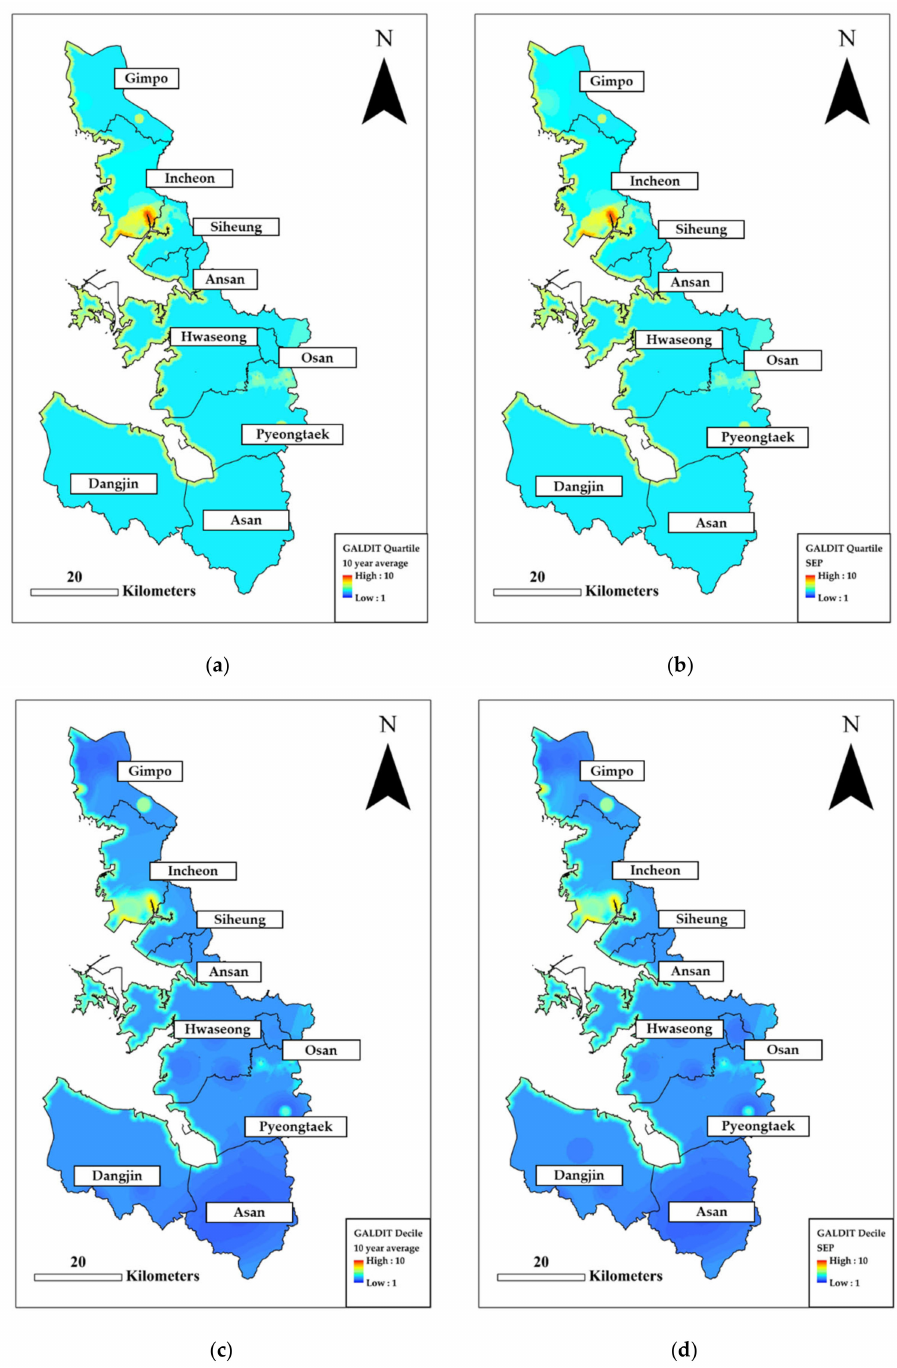
Figure 13. Comparison of ( a ) 10-year-averaged GALDIT in original quartile classification, ( b ) GALDIT in September in original quartile classification, ( c ) 10-year-averaged GALDIT in decile classification, and ( d ) GALDIT in September in decile